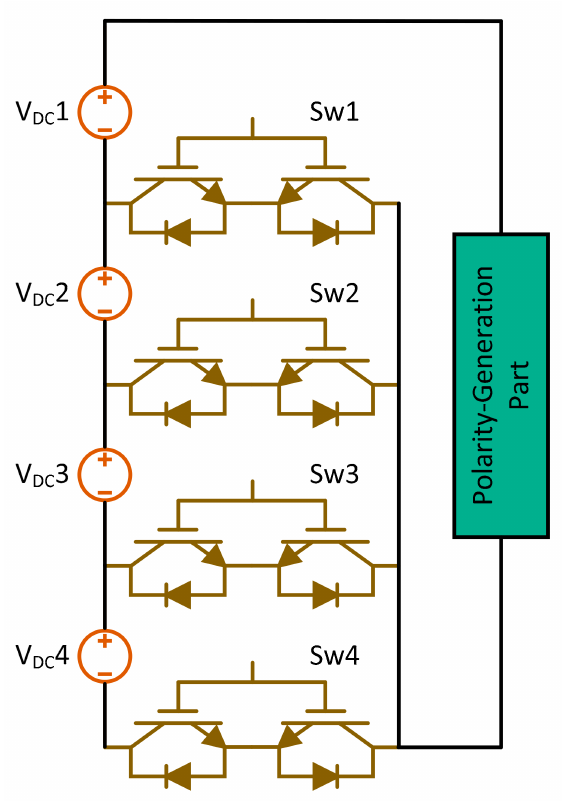
Figure 18. Topology of multilevel module based multilevel